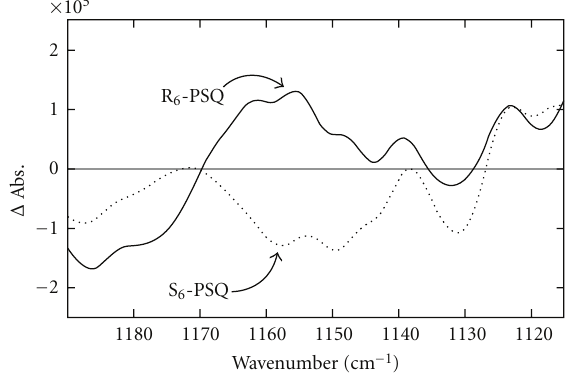
Figure 4: VCD spectra in DMSO of R 6 - and S 6 -PSQs.